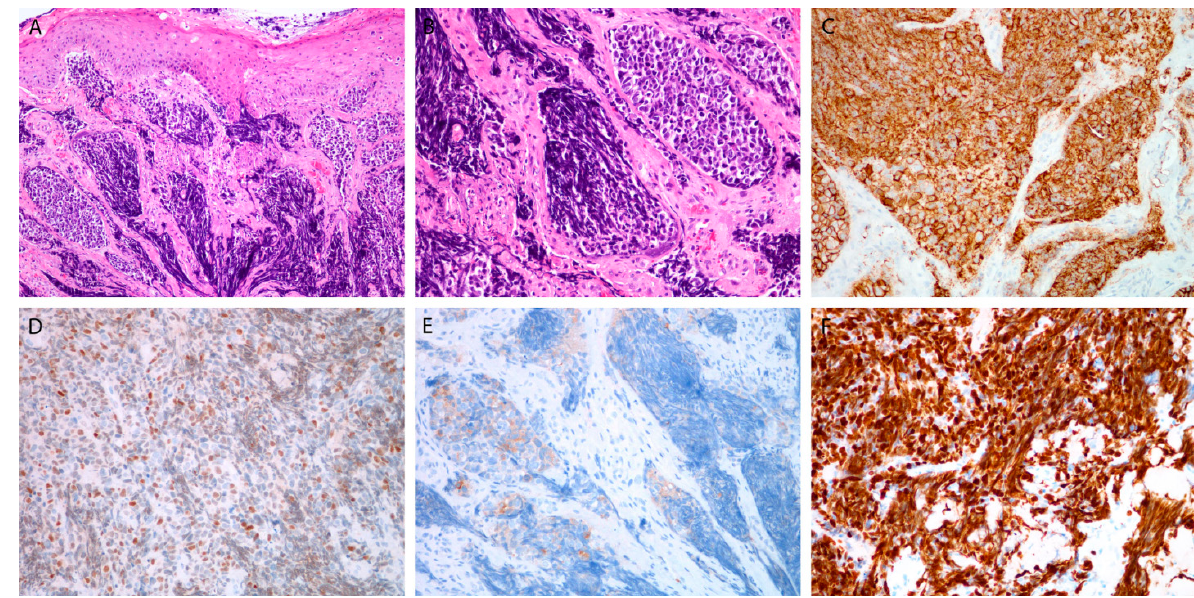
Figure 3. Small cell poorly differentiated neuroendocrine carcinoma. Tumor beneath the surface epithelium, composed of small hyperchromatic cells, with extensive crush artifacts ( A and B ). Immunohistochemical staining for CD56 ( C ), INSM1 ( D ), synaptophysin ( E ), and Ki-67 in almost all tumor cells ( F ). Magnification 10 × 10 (A and C), 10 × 20 (B, D–F).